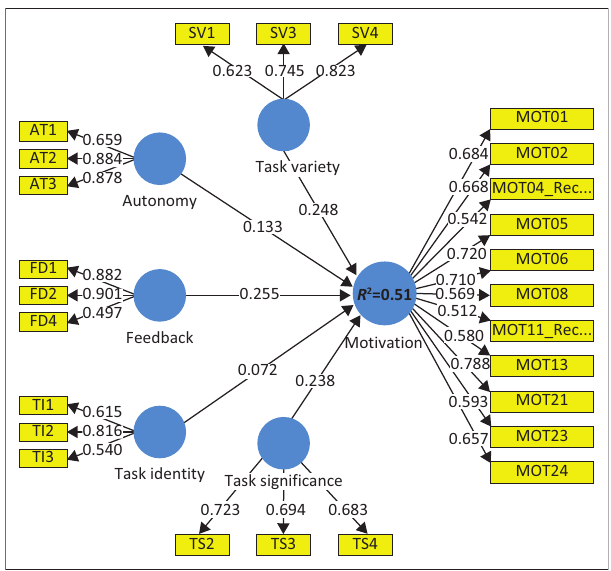
FIGURE 2 : The partial least squares structured equation modelling model for the impact of job characteristics on the motivation of millennial